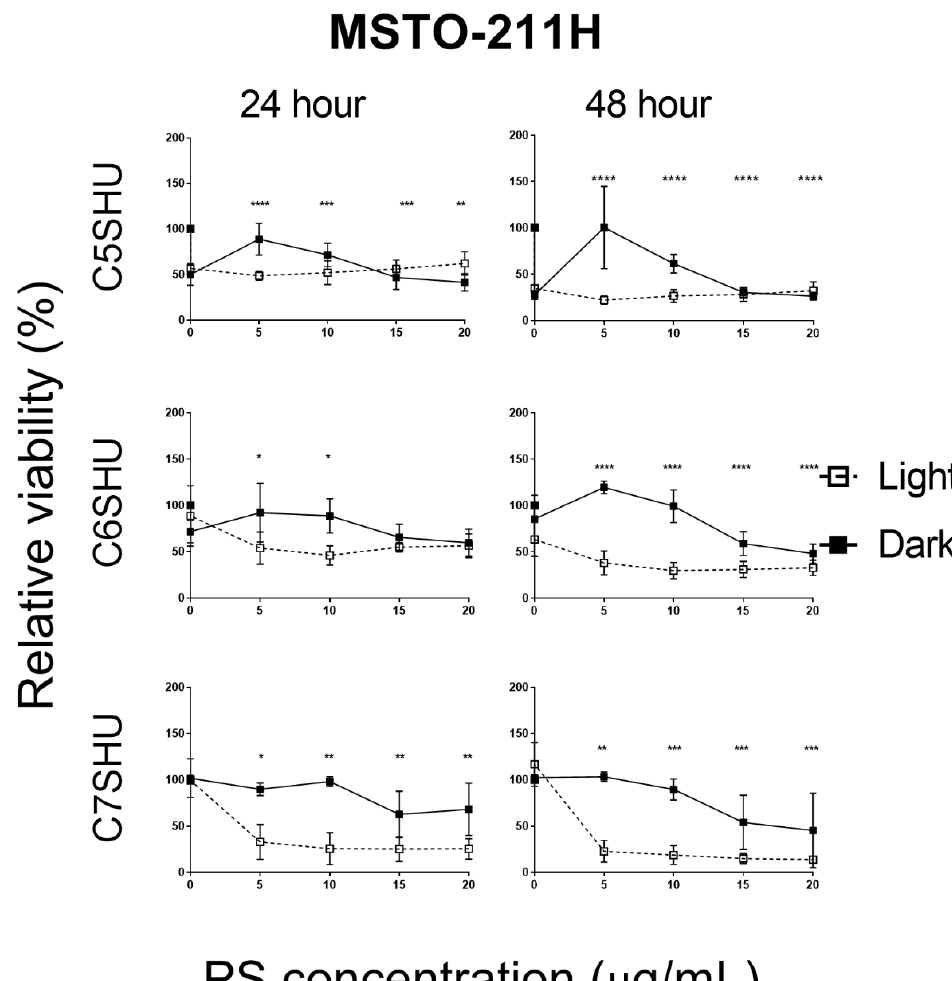
The MSTO-211H cell line demonstrated a sensitivity to all three PS C5SHU, C6SHU and C7SHU in both the 24 h and 48 h treatments (Figure 4). The C5SHU demonstrated a strong PDT reduction in cell viability from the 5 µ g/mL treatment at the 48-h time point (22 vs. 100% viability in light and dark treatment conditions, respectively). However, further confirmation is needed due to the low viability in vehicle control treatments ( ≤ 35%) and the substantial dark toxicity at 15 and 20 µ g/mL concentrations (30 and 26%, respectively after 48 h). C6SHU gave a defined PDT effect from the 5 µ g/mL treatment at the 48-h time point (38 and 119% viability in light and dark treatment conditions, respectively) but not at the 24 h time point.